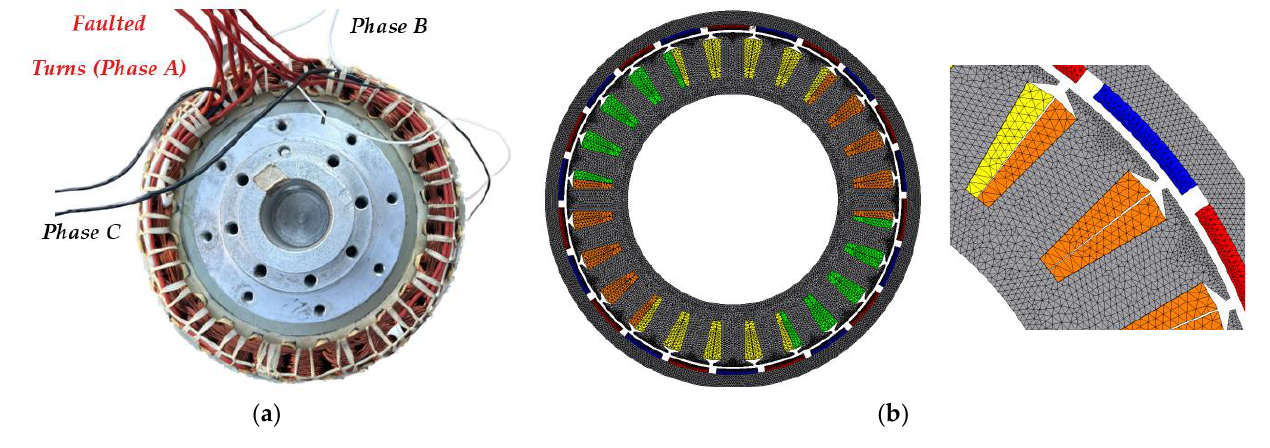
Figure 8. ER-PMSM with LTs in phase A. ( a ) ER-PMSM stator winding with LTs fault in phase A; ( b ) the mesh of the ER-PMSM FEA analysis.